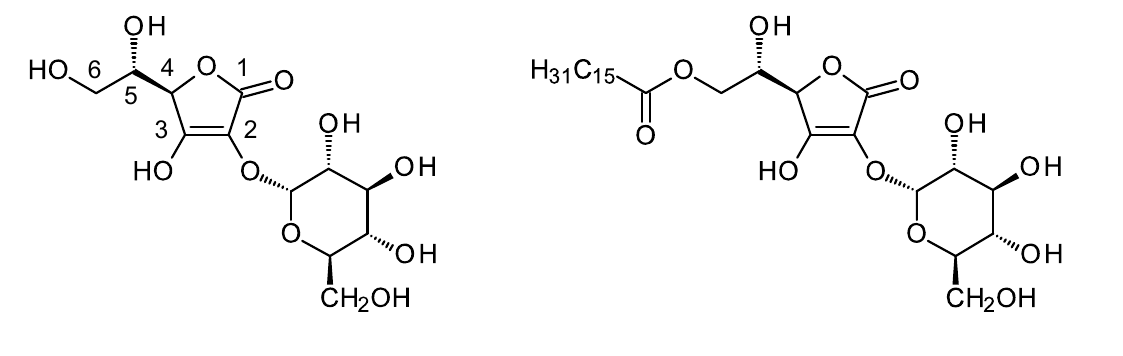
Figure 1. Structures of AA-2G and 6-sPalm-AA-2G.